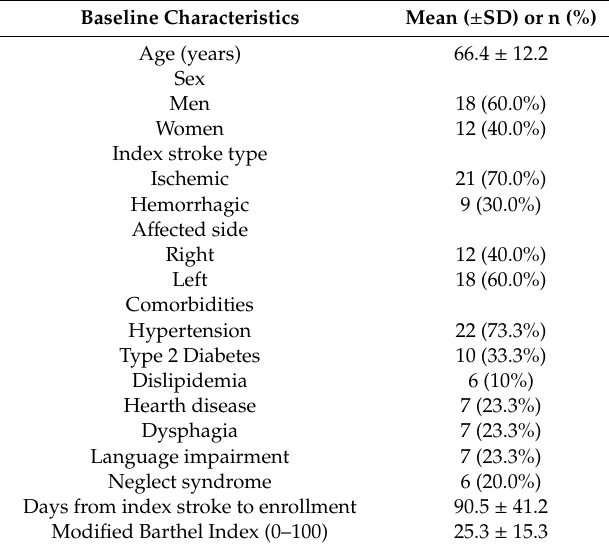
Table 1. Baseline characteristics of the sample (n = 30).